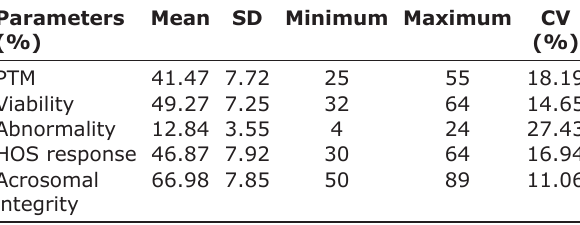
Table-1: Descriptive statistics of different semen freezability parameters in Jakhrana